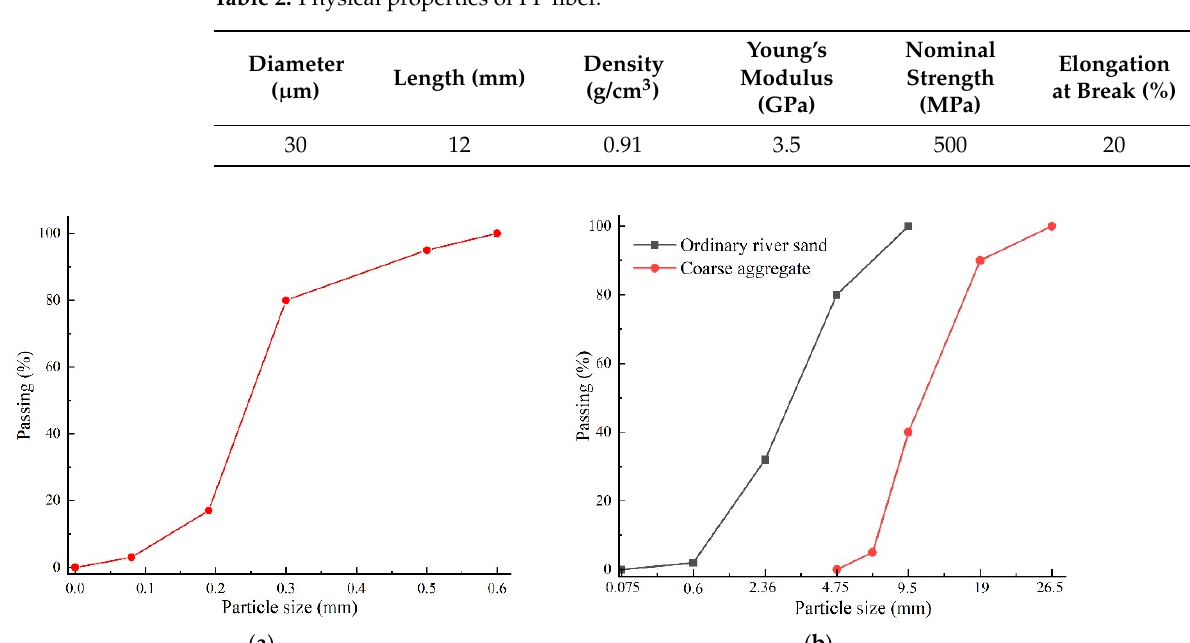
Table 1. Main components and properties of binders.